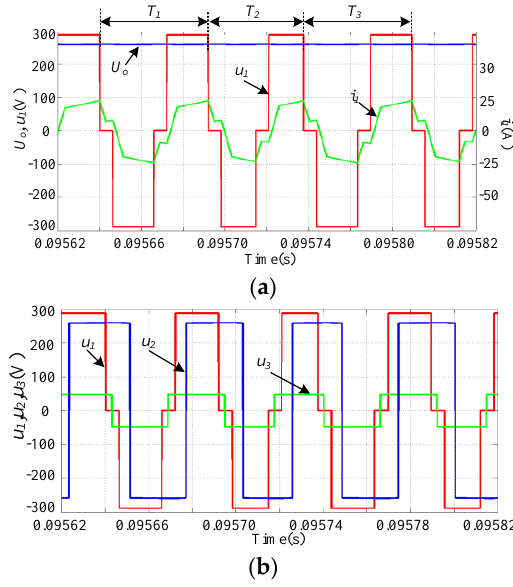
Figure 20. Simulated waveforms of phase-shifted PWM control with discretely chaotic modulation: ( a ) converter voltage, current of port 1 and output voltage of port 2; ( b ) converter voltages of port 1, 2 and 3.